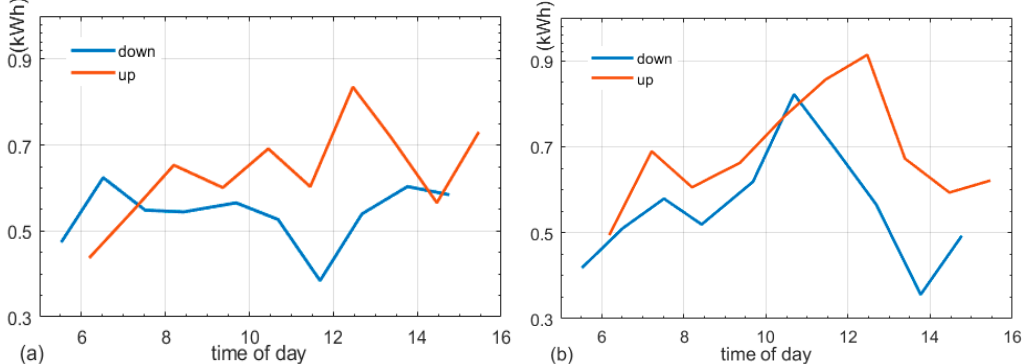
Figure 3. Mean energy consumption for upward and downward bus trips during a day in ( a ) winter and ( b ) summer.